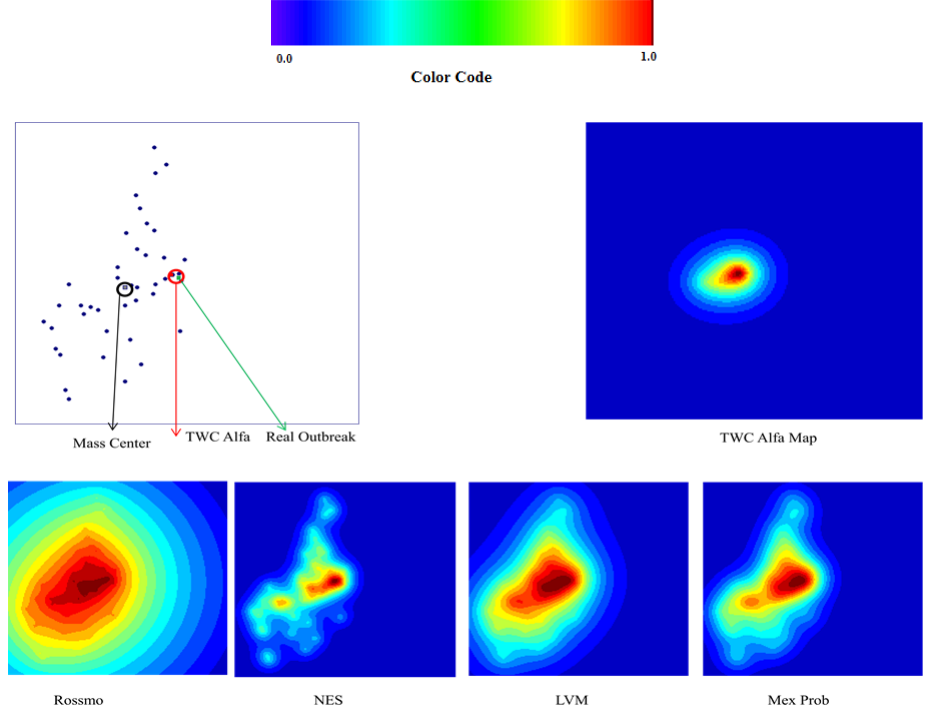
Figure E4. The Russian influenza in Sweden in